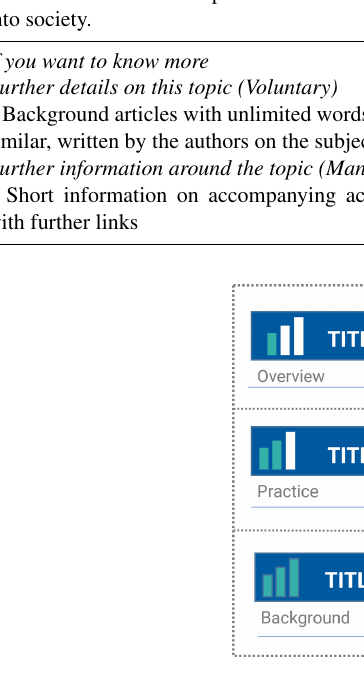
Figure 7. Interest-labelling including tasks for map- and story-based contributions, with tasks regarding the interest labels.